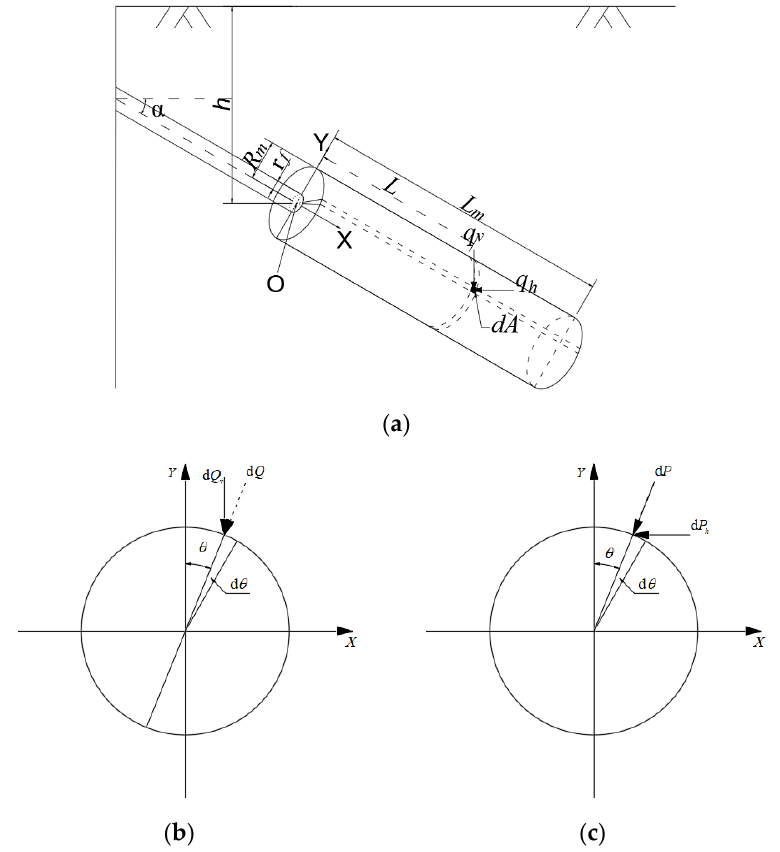
Figure 10. Integral diagram of vertical and horizontal soil pressure: ( a ) model diagram; ( b ) vertical component of soil pressure; ( c ) horizontal component of soil pressure.